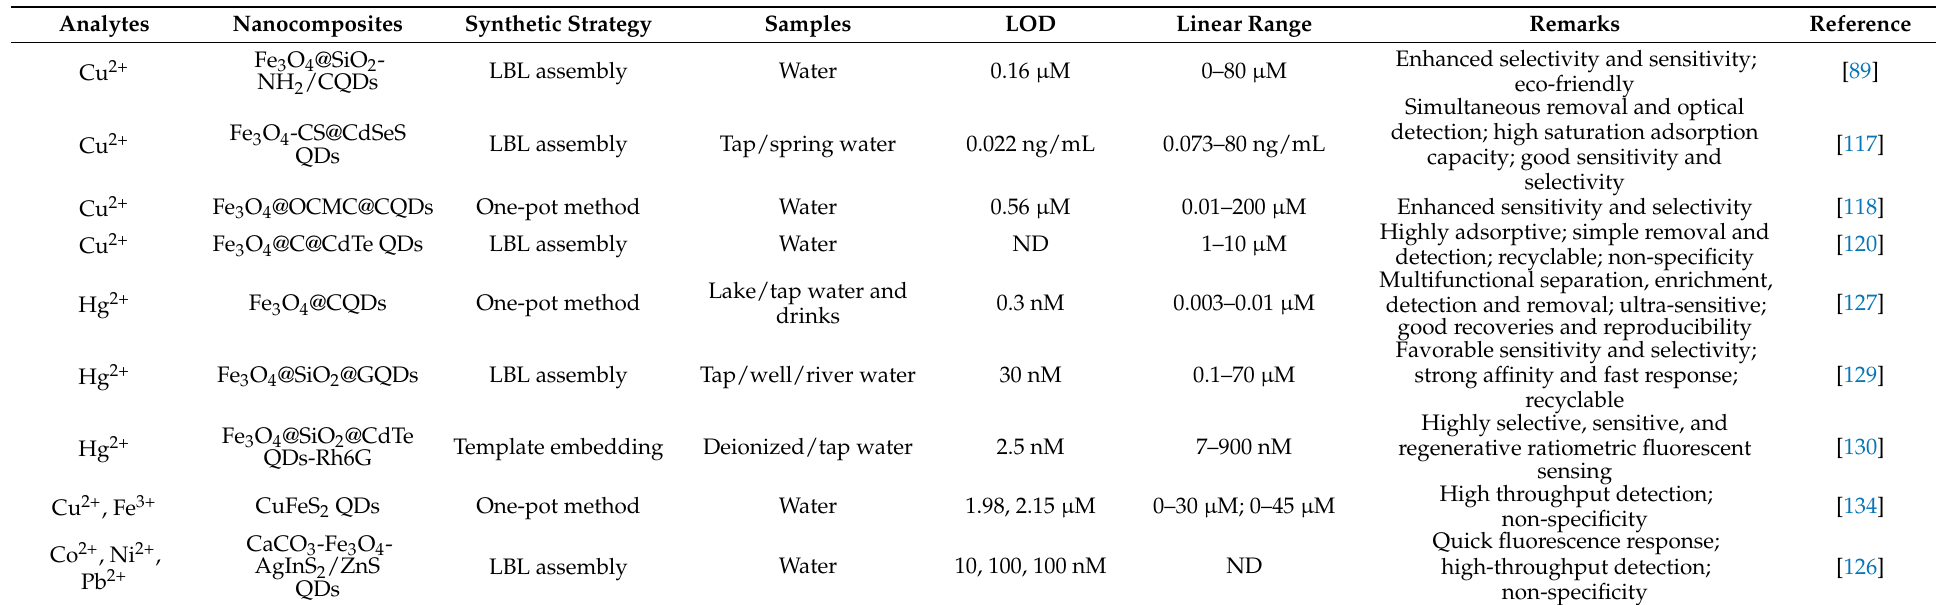
Table 1. Detection performances of MNPs@QDs-based sensors for metal